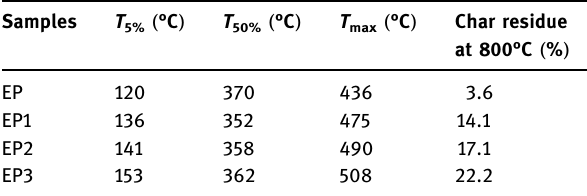
Table 5: TG data of fl ame retarded EP Samples